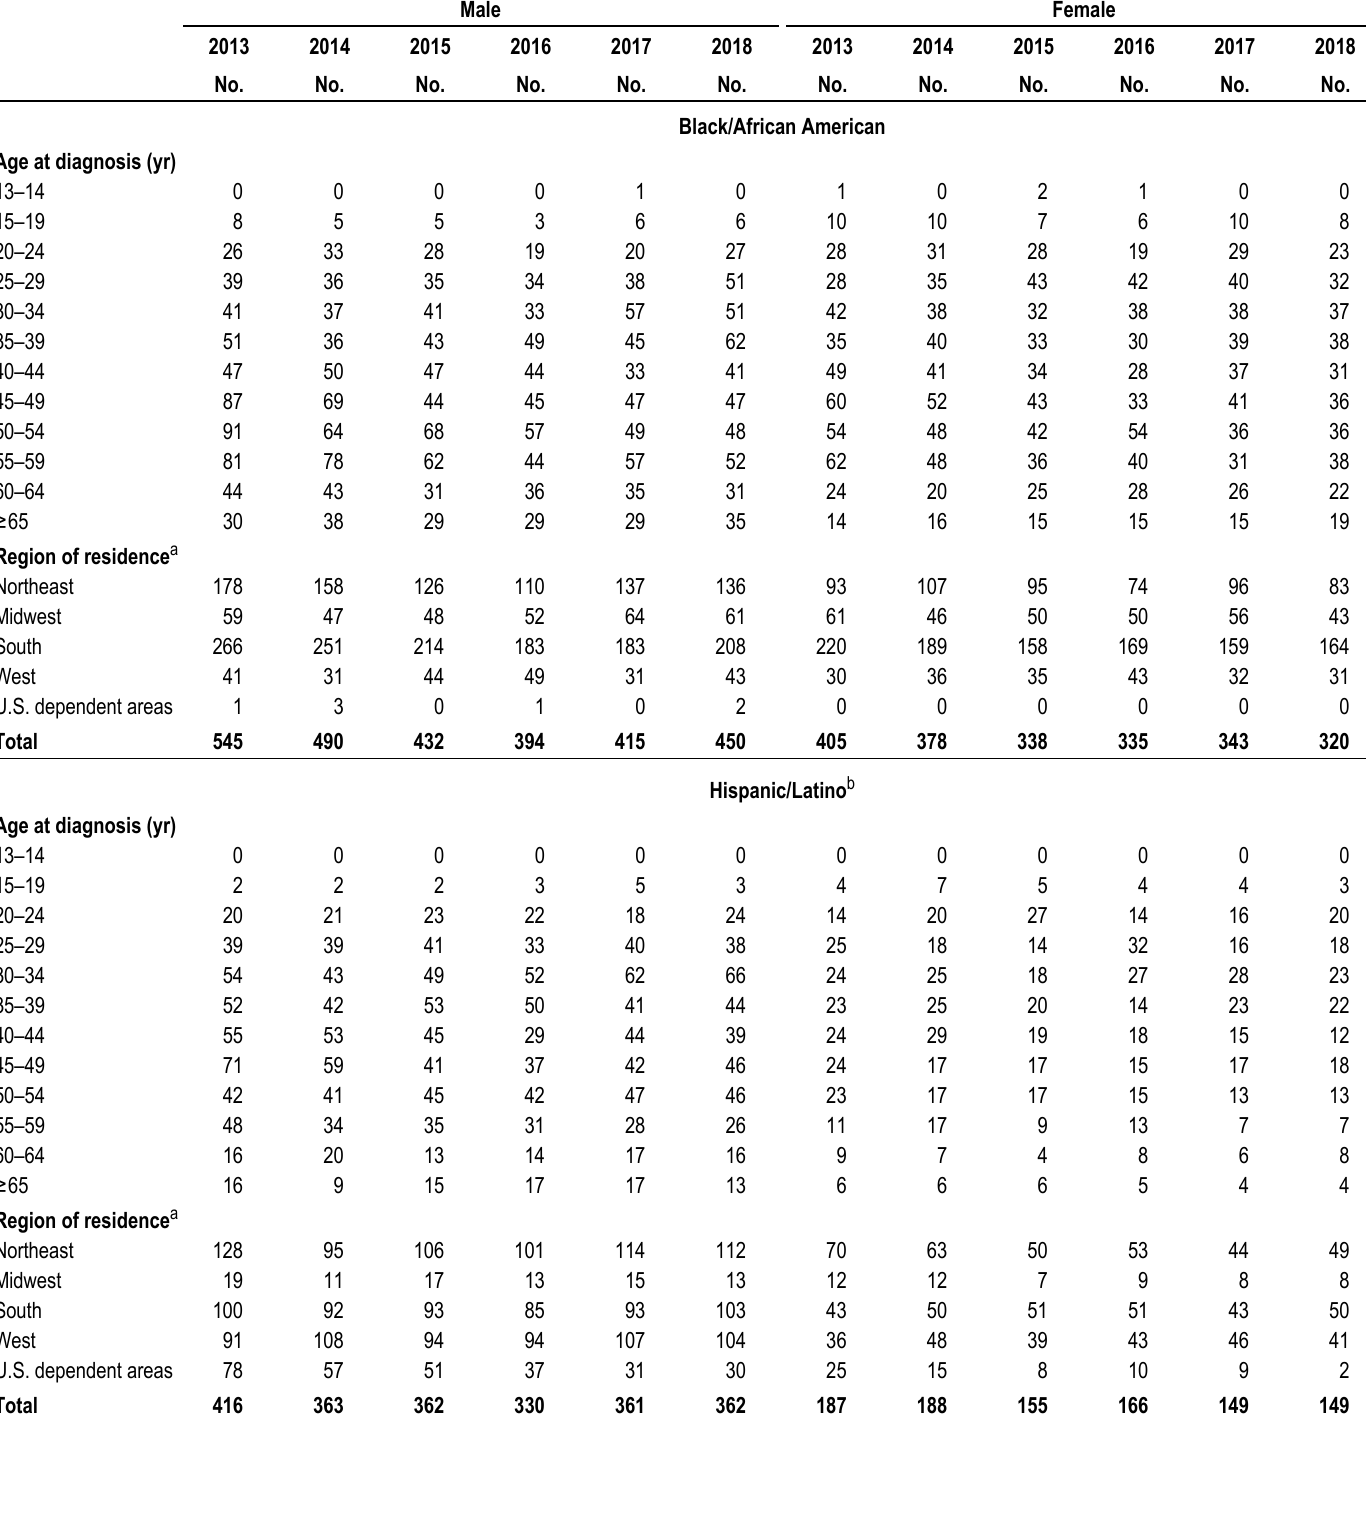
Table 8b. Diagnoses of HIV infection attributed to injection drug use, by selected characteristics, 2013–2018—United States and 6 dependent areas